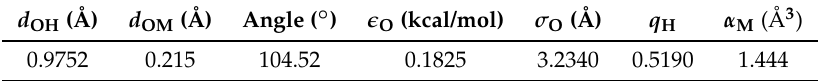
Table 1. Characteristics of the Dang-Chang water model. The oxygen atoms interact via a Lennard- Jones potential. The negative charge and the dipole are carried by the fourth site